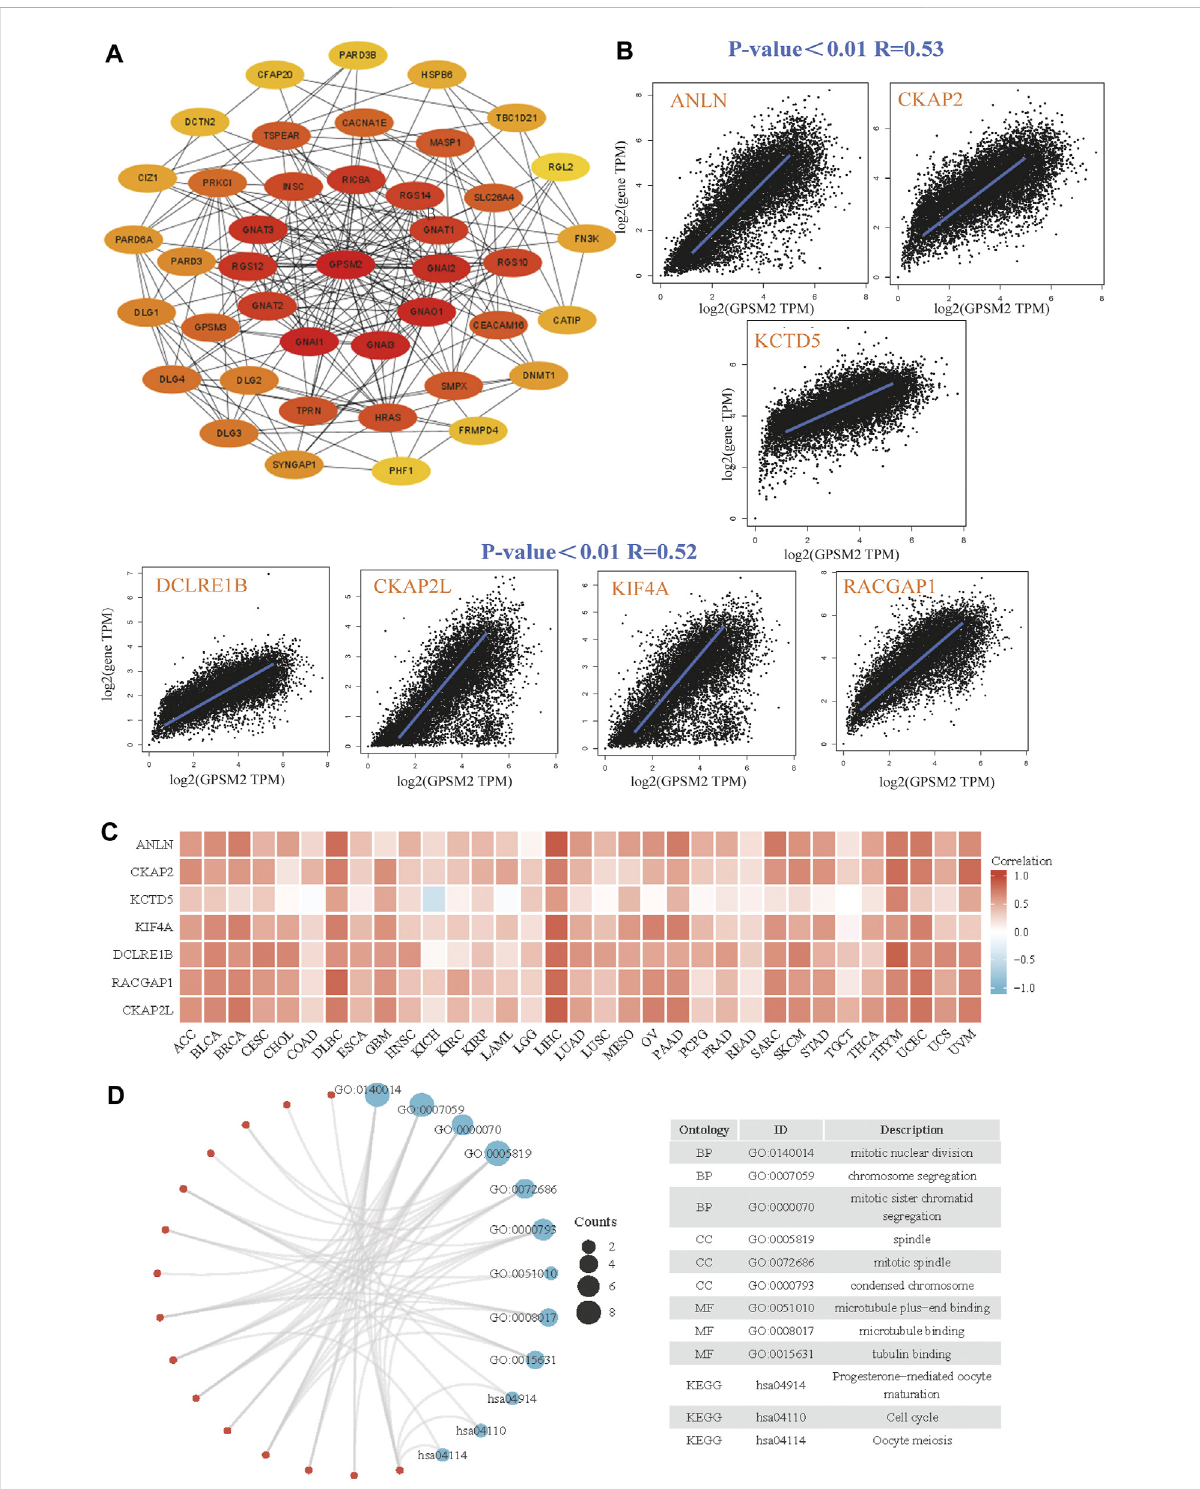
FIGURE 9 Enrichment and pathway analysis of GPSM2 -related genes. (A) Known GPSM2 binding-protein string network. (B) The GEPIA2 dataset shows the expression correlation between GPSM2 and representative genes (ANLN, CKAP2, KCTD5, DCLRE1B, CKAP2 L, KIF4A, and RACGAP1) of the top GPSM2 -correlated genes. (C) In TCGA pan-cancer, GPSM2 expression and ANLN, CKAP2, KCTD5, DCLRE1B, CKAP2 L, KIF4A, and RACGAP1 were correlated with the heatmap. (D) GO|KEGG pathway analysis based on GPSM2 and its interacting